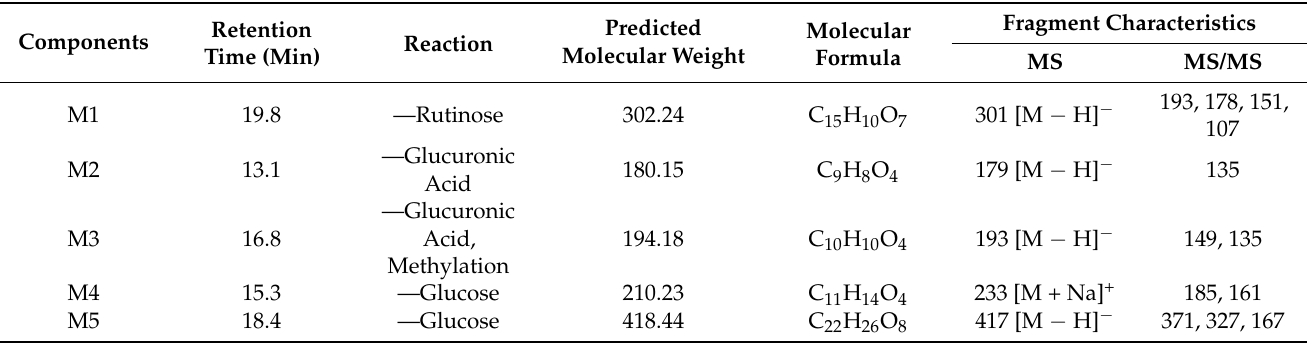
Table 2. Characteristics of main metabolites of main components ( Saussurea involucrata ) in gut microbiota by LC/MS n